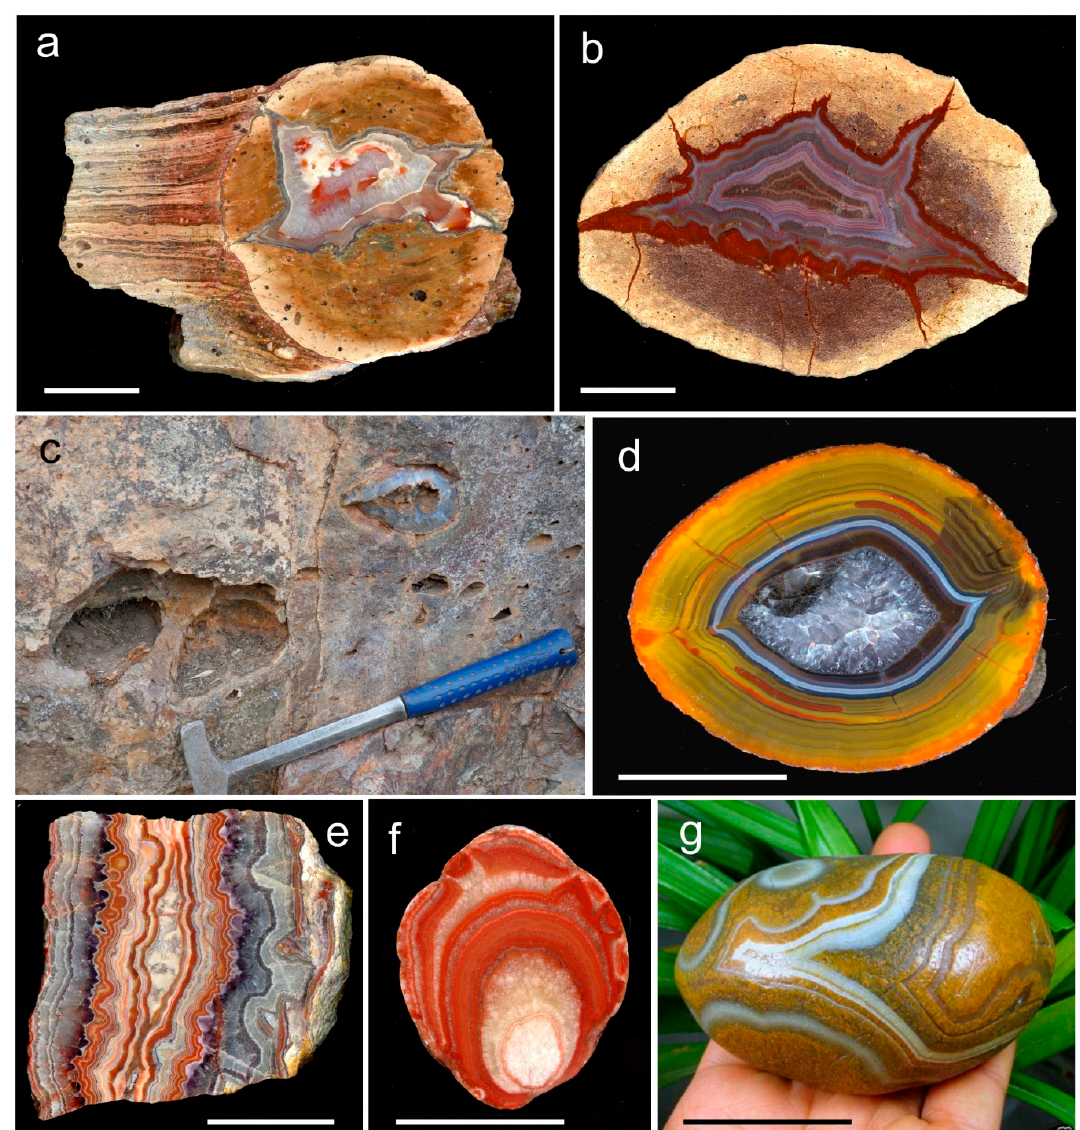
Figure 2. Compilation showing the different main agate types; ( a ) lithophysa (thunderegg) within the flow texture of the rhyolitic host rock from Nesselhof, Thuringia (Germany); ( b ) large thunderegg with agate from rhyolitic ignimbrite of St. Egidien (Saxony, Germany); ( c ) andesitic host ‐ rock with both empty and agate ‐ filled vesicles at the Rancho Coyamito (Chihuahua, Mexico); ( d ) finely banded agate from a trachyandesitic host ‐ rock of Xuanhua (Hebei province, China); ( e ) hydrothermal vein agate in metamorphic host rocks (gneisses) from Röthenbach (Saxony, Germany); ( f ) sedimentary banded microcrystalline granular quartz from a clay seam in carbonate host ‐ rocks from Dulcote (Mendip, UK); ( g ) clastic agate pebble from river sediments of the Yangtze river near Nanjing (Jiangsu province, China); Scale bar is 5 cm.